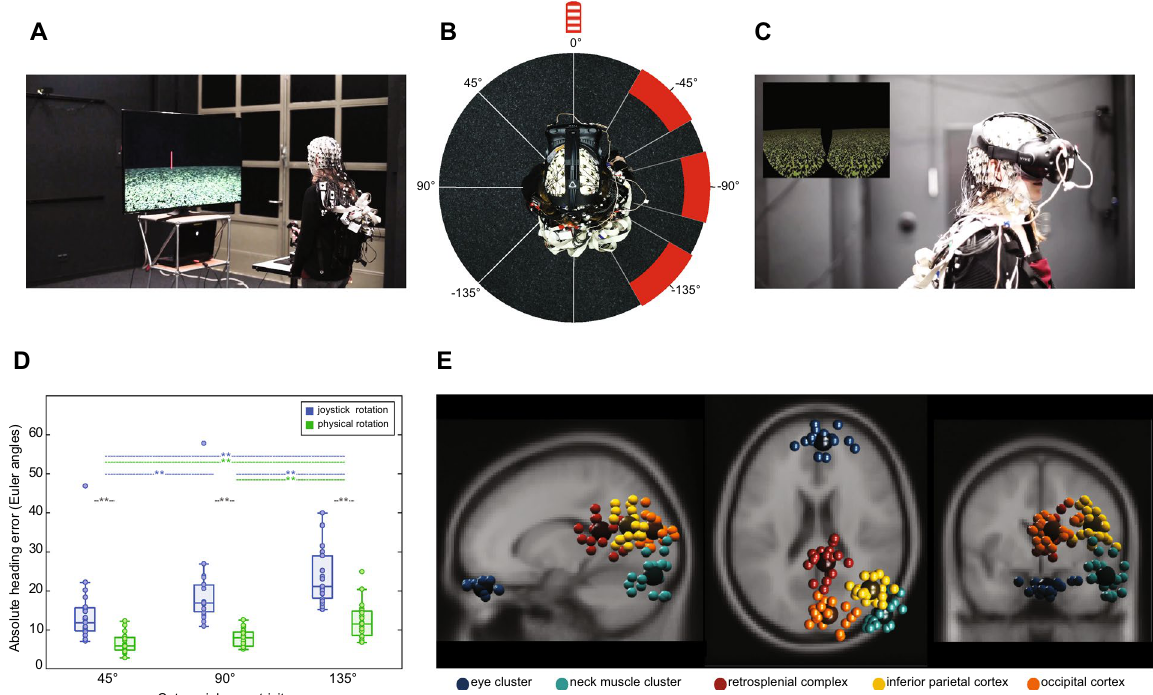
Figure 1. Experimental setup, heading error and representative IC-cluster. ( A ) Setup of the stationary condition with joystick rotation (joyR; visual flow only), displaying a sparse virtual environment with a local landmark providing the initial heading direction (pole). The joystick was placed on a table in front of the standing participant. ( B ) Top-down view of a participant in the physical rotation (physR) condition with MoBI setup, displaying the rotation eccentricities (categorial eccentricities varying ± 15° around 45°, 90°, and 135°, respectively). ( C ) MoBI setup with a participant wearing high-density EEG synchronized to motion capture (red LEDs on VR goggle) and a head-mounted VR. The inset displays the binocular view of the virtual environment. ( D ) Absolute heading error (orientation yaw; Euler angles) after completing the back rotation, displayed for both rotation conditions as a function of eccentricity, averaged across rotation directions. The boxplot comprises all participants (median; whiskers extending to 1.5 times the interquartile range). Bonferroni-significant p-values of post hoc testing are shown (Wilcoxon signed-rank test). **Indicates p < 0.01. ( E ) Representative clusters of independent components (ICs) with single ICs displayed as small spheres and cluster centroid displayed as larger spheres. ICs are projected onto a standard brain (MNI) with sagittal, horizontal and coronal views from left to right. Cluster centroid in Talairach space for a cluster representing eye movement activity (blue; x = 4, y = 46, z = − 28; no BA); a cluster representing right neck muscle activity (light blue; x = 54; y = − 85, z = − 10; no BA); a cluster representing activity originating in or near the restrosplenial complex (RSC) (dark red; x = 8, y = − 42, z = 18; BA30); a cluster representing activity originating in or near the right inferior parietal cortex (yellow; x = 44, y = − 63, z = 23; BA39); a cluster representing activity originating in or near the occipital cortex (orange; x = 9, y = − 81, z = 20;